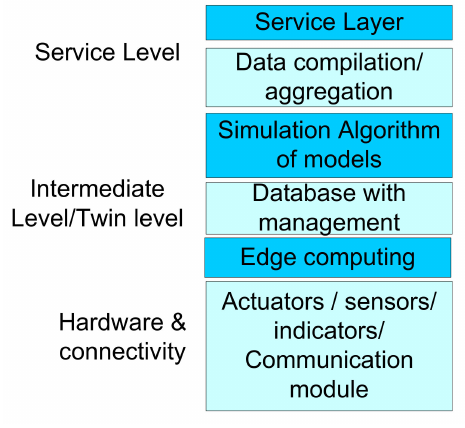
Figure 10. Layers of Architecture.